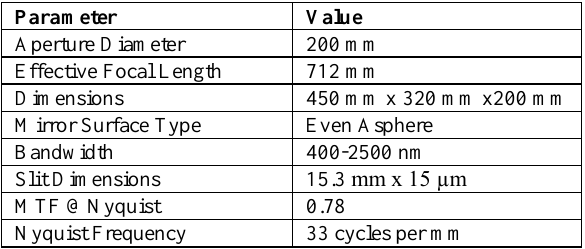
Table 5. Off-axis TMA optical design parameters